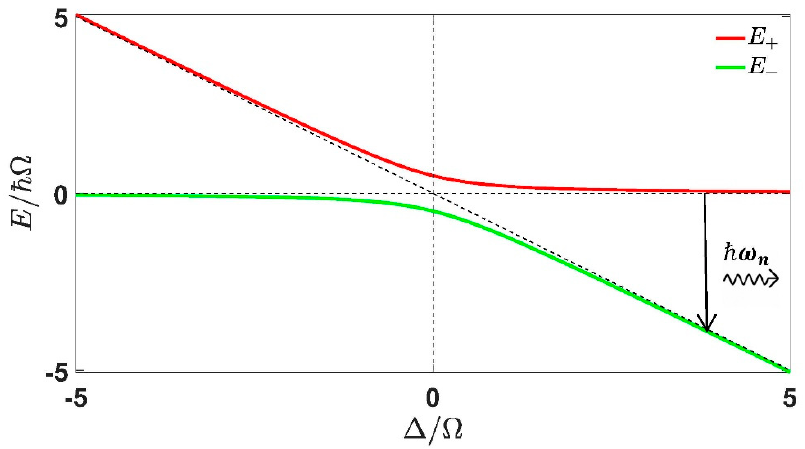
Figure 2. The dressed state energy variation with Δ/Ω is shown. The slant dashed line represents the energy of |2⟩ state with value −ℏΔ and the horizontal dashed line represents the energy of state |1⟩ , when there is no coupling between the bare QD states and the classical light. The solid vertical arrow represents transition from the upper dressed state to lower dressed state when detuning is (cid:12) (cid:12) sufficiently high so that | ψ > − ≈ (cid:12) 2 > and | ψ > + ≈ (cid:12) 1 > and the emitted phonon has the